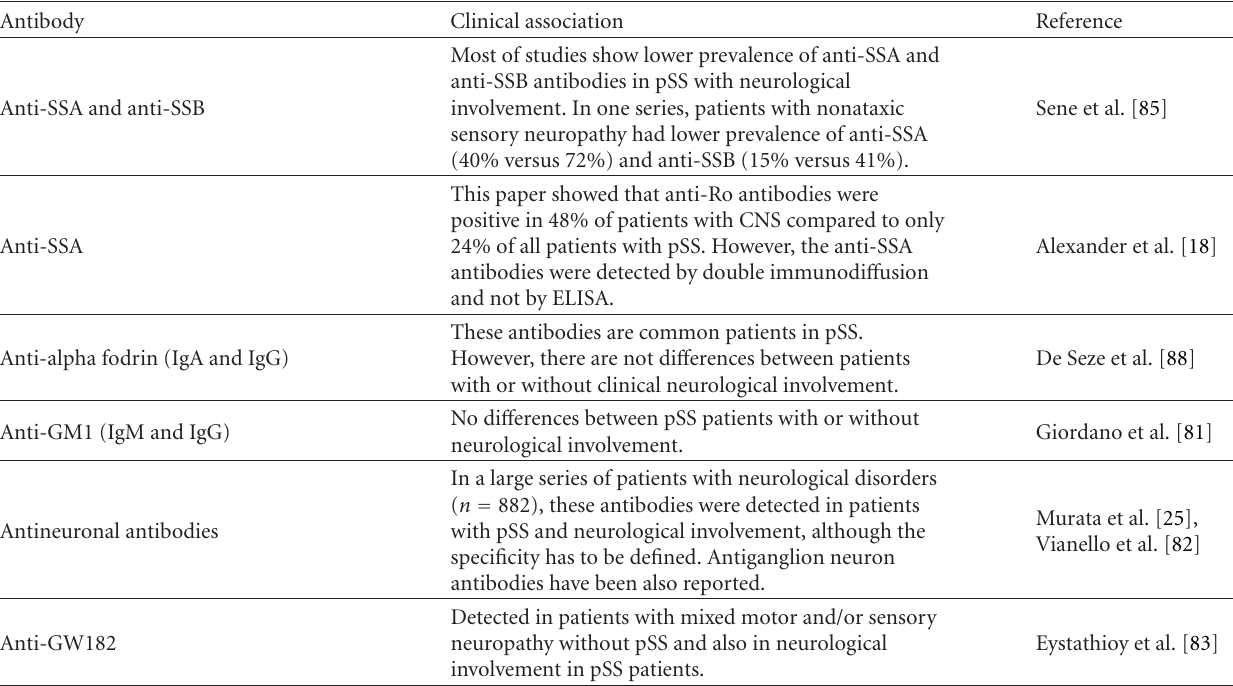
Table 2: Antibodies in neurological manifestations of primary Sj¨ogren’s